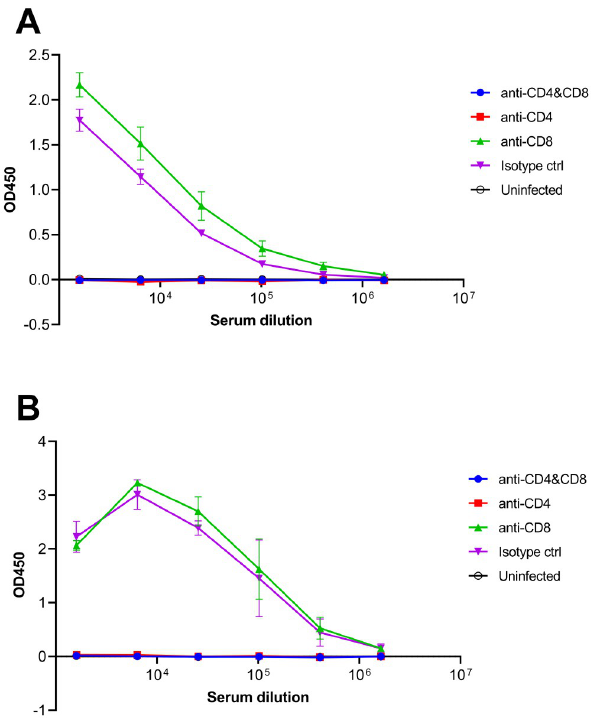
Fig 5. Antibody response against LASV in T-cell-depleted mice. Anti-LASV GPC (A) or NP (B) antibodies were detected by ELISA. Numbers of available serum samples are following; CD4/CD8-depleted group (n = 4), CD4-depleted group (n = 2), CD8-depleted group (n = 3), isotype control group (n = 2), and uninfected group (n = 5).